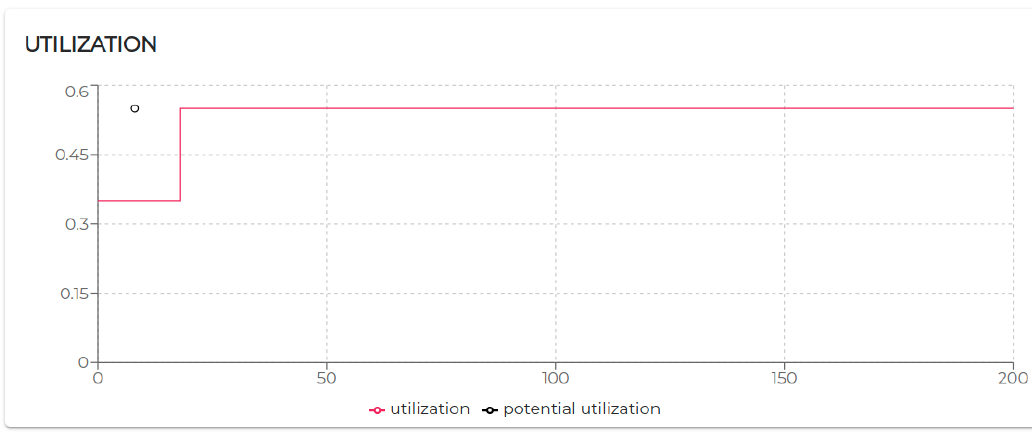
Figure 10. Utilization factor of agent 2 [0–200 s] in scenario S1; y-axis: utilization (adimensional); x-axis: time